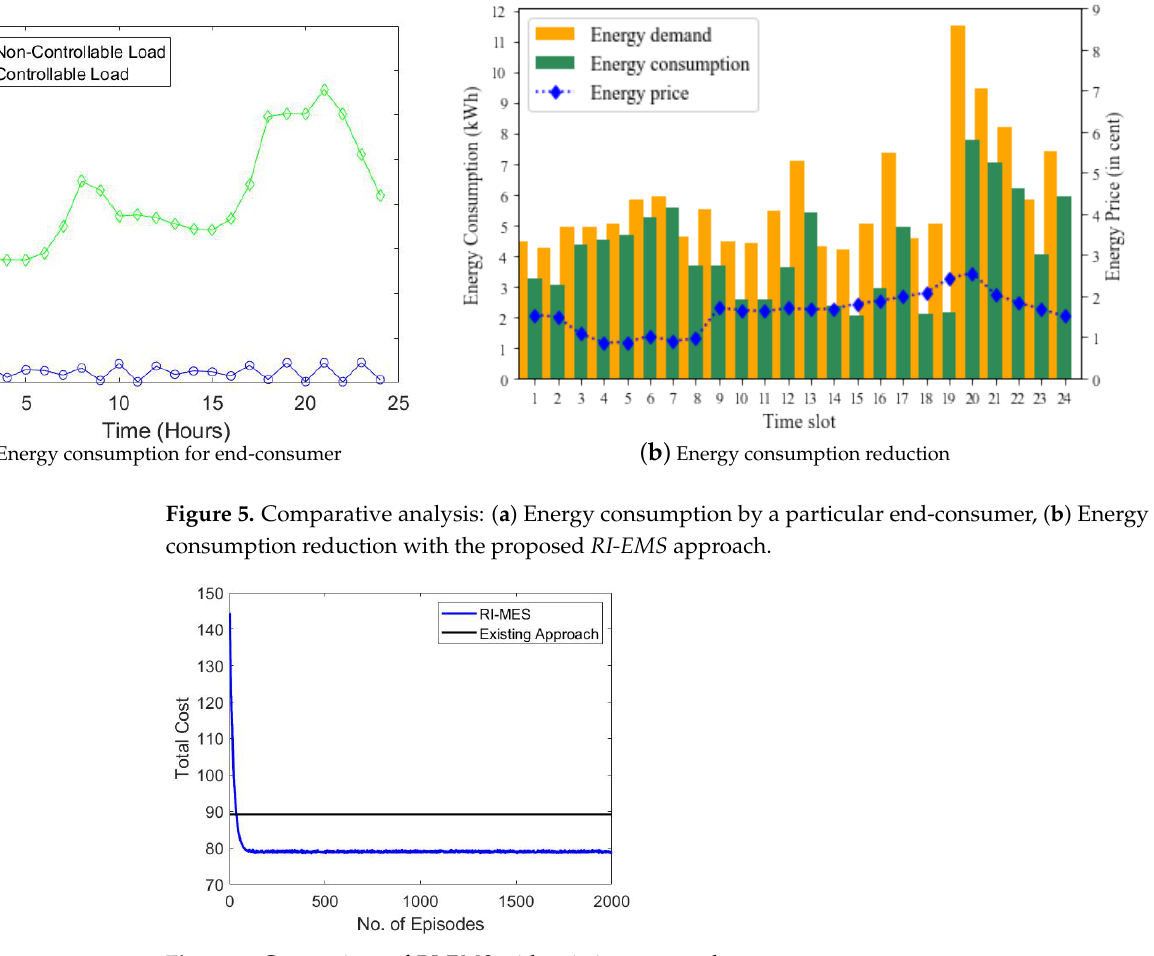
Figure 6. Comparison of RI-EMS with existing